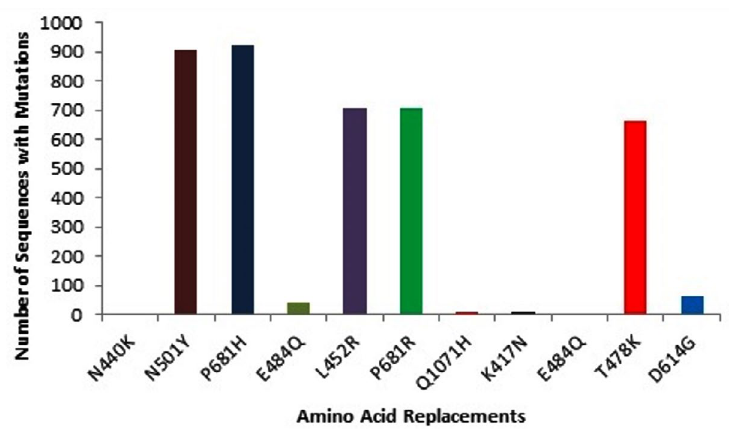
Fig2. Frequency of the amino acid replacement. These amino acid replacements were shared by many variants in the current study. Among all the frequency of P681H replacement was observed to be higher followed by N501Y, L452R, P681R and T478K. The frequency of rest of the replacements was observed negligible.